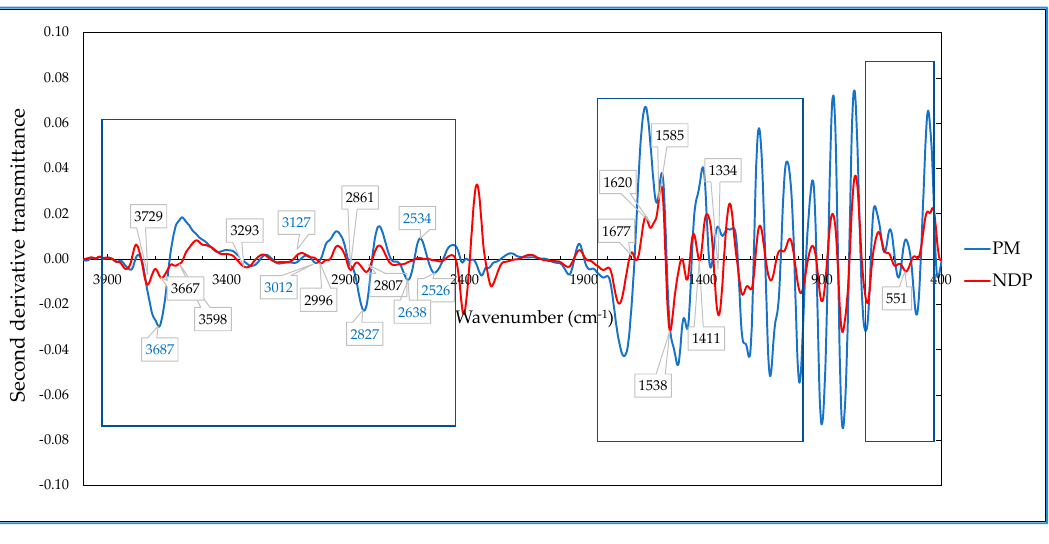
Figure 3. ( a ) FTIR spectra of diclofenac sodium hydrate (NDH), L-proline (LP), physical mixture 1:1 (PM), and the multicomponent 1:1 (NDP) from ethanol, methanol, and acetone. All NDPs have similar spectra, therefore only one of NDP spectra is marked on value of wavenumber changes. ( b ) The 2 nd derivative FTIR spectra of NDP and PM. The blue number belongs to PM, and the black number reflects the NDP bands.